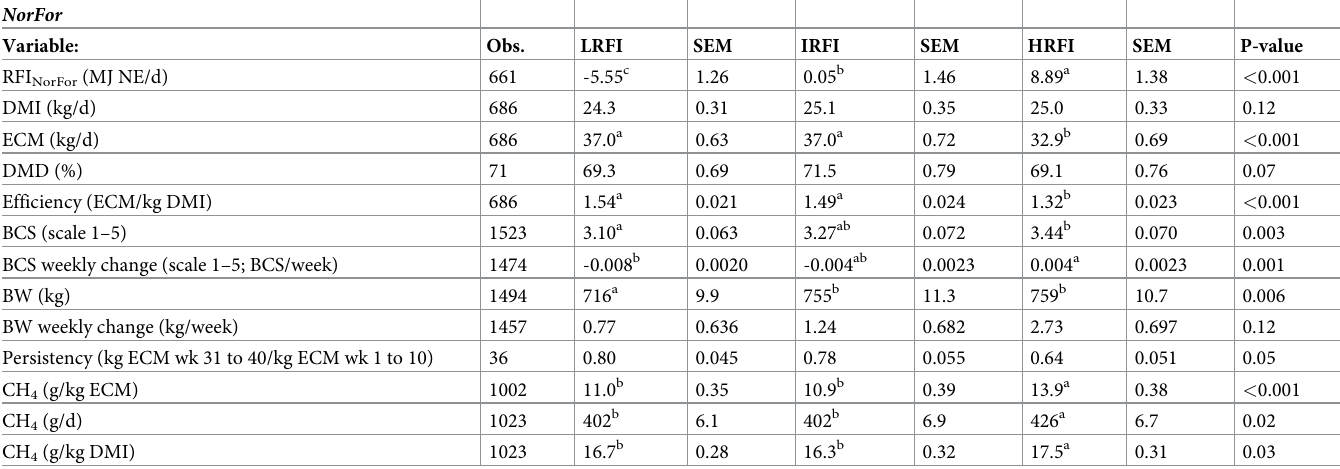
Table 4. Full-lactation performance (least square mean and SEM) of cows divided into two groups, with low residual feed intake (LRFI; n = 12), intermediate (IRFI; n = 12) or high RFI (HRFI; n = 12) according the NorFor (2011) equation (for parameter abbreviations, see main text). NorFor Variable: Obs.